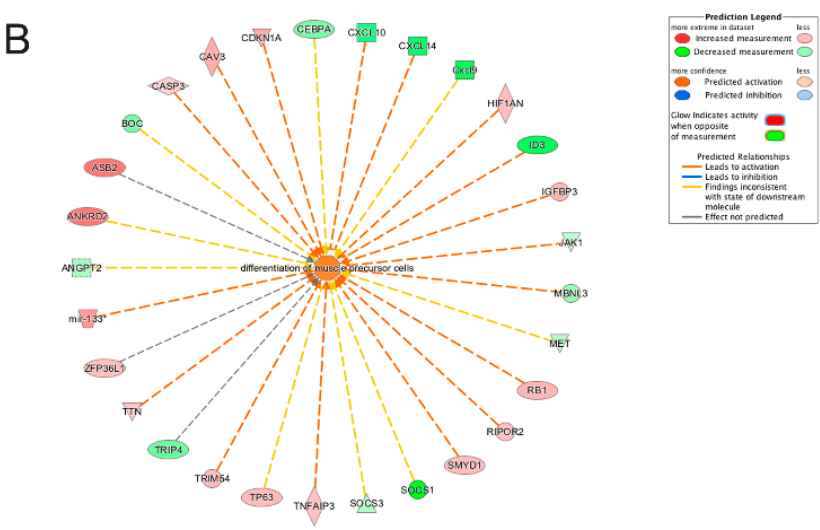
Figure 12. Ingenuity pathway analysis of genes differentially expressed during the transition from differentiation day 0 to day 1 common to emerin-null cells and wildtype cells. ( A ) The Cell Cycle G1/S checkpoint regulation pathway is significantly enriched in both wildtype and emerin-null cell during transition from day 0 to day 1 of differentiation. The network was generated through the use of IPA (Ingenuity Systems, www.ingenuity.com) on normalized mRNA values. Nodes represent molecules in a pathway, while the biological relationship between nodes is represented by a line (edge). Edges are supported by at least one reference in the Ingenuity Knowledge Base. The intensity of color in a node indicates the degree of up- (red) or down- (green) regulation. Brown colored nodes (up-regulation) and blue colored nodes (down-regulation) indicate additional nodes in the pathway that are uniquely altered in emerin-null cells. Nodes are displayed using shapes that represent the functional class of a gene product (Circle = Other, Nested Circle = Group or Complex, Rhombus = Peptidase, Square = Cytokine, Triangle = Kinase, Vertical ellipse = Transmembrane receptor). Edges are marked with symbols to represent the relationship between nodes (Line only = Binding only, Flat line = inhibits, Solid arrow = Acts on, Solid arrow with flat line = inhibits and acts on, Open circle = leads to, Open arrow = translocates to). ( B ) Biological Function Analysis predicts activation of differentiation of muscle precursor cells in both wildtype cells and emerin-null cells during transition from day 0 to day 1 of differentiation ( p -value: <0.001; Z -score: 1.350). The figure represents genes that are associated with a particular biological function that are altered in the uploaded dataset. Genes that are up-regulated are displayed within red nodes and those down-regulated are displayed within green nodes. The intensity of the color in a node indicates the degree of up-(red) or down-(green) regulation. The shapes of the nodes reflect the functional class of each gene product: transcriptional regulator (horizontal ellipse), transmembrane receptor (vertical ellipse), enzyme (vertical rhombus), cytokine/growth factor (square), kinase (inverted triangle) and complex/group/other (circle). An orange line indicates predicted upregulation, whereas a blue line indicates predicted downregulation. A yellow line indicates expression being contradictory to the prediction. Gray line indicates that direction of change is not predicted. Solid or broken edges indicate direct or indirect relationship,